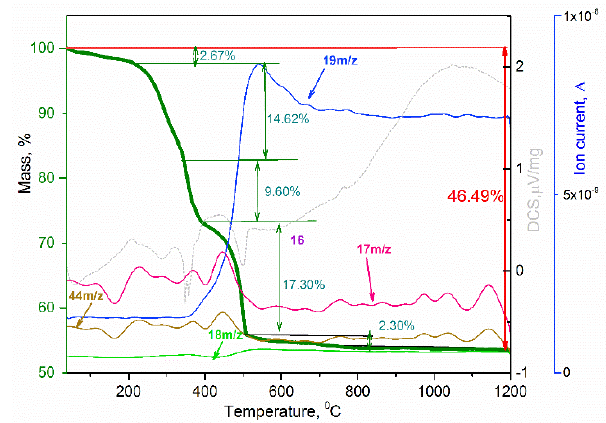
Figure 2. TGA-MS analysis of NH 4 TiOF 3 at air